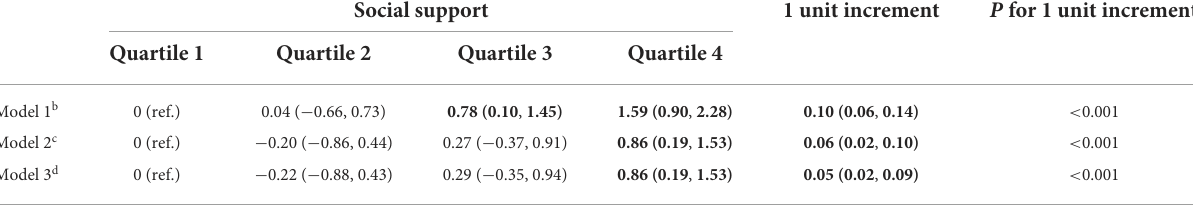
TABLE 3 Relationship between the social support and score in MMSE in multiple linear regression analysis a .